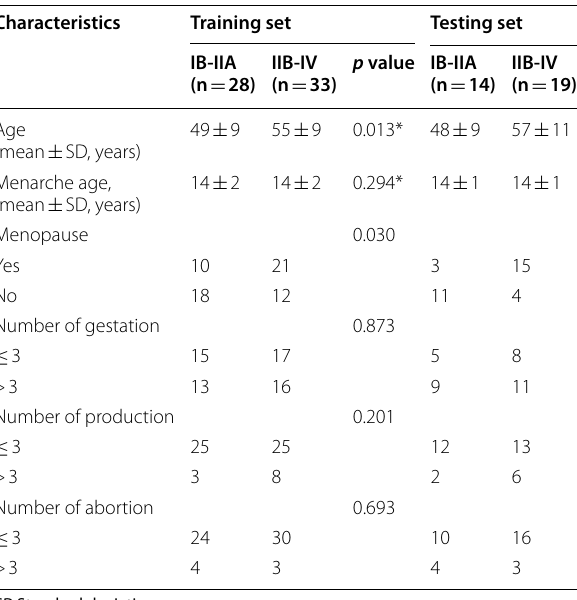
Table 3 Comparison of clinical data between patients with early and advanced cervical cancer in the training and testing